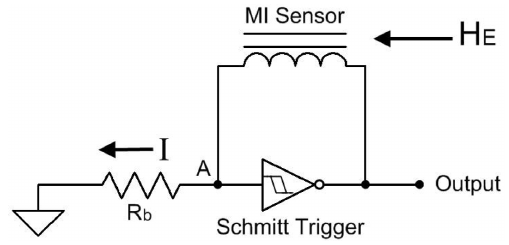
Figure 2. Schematics of the electronics involved in the magneto- inductive technology (from Leuzinger and Taylor,